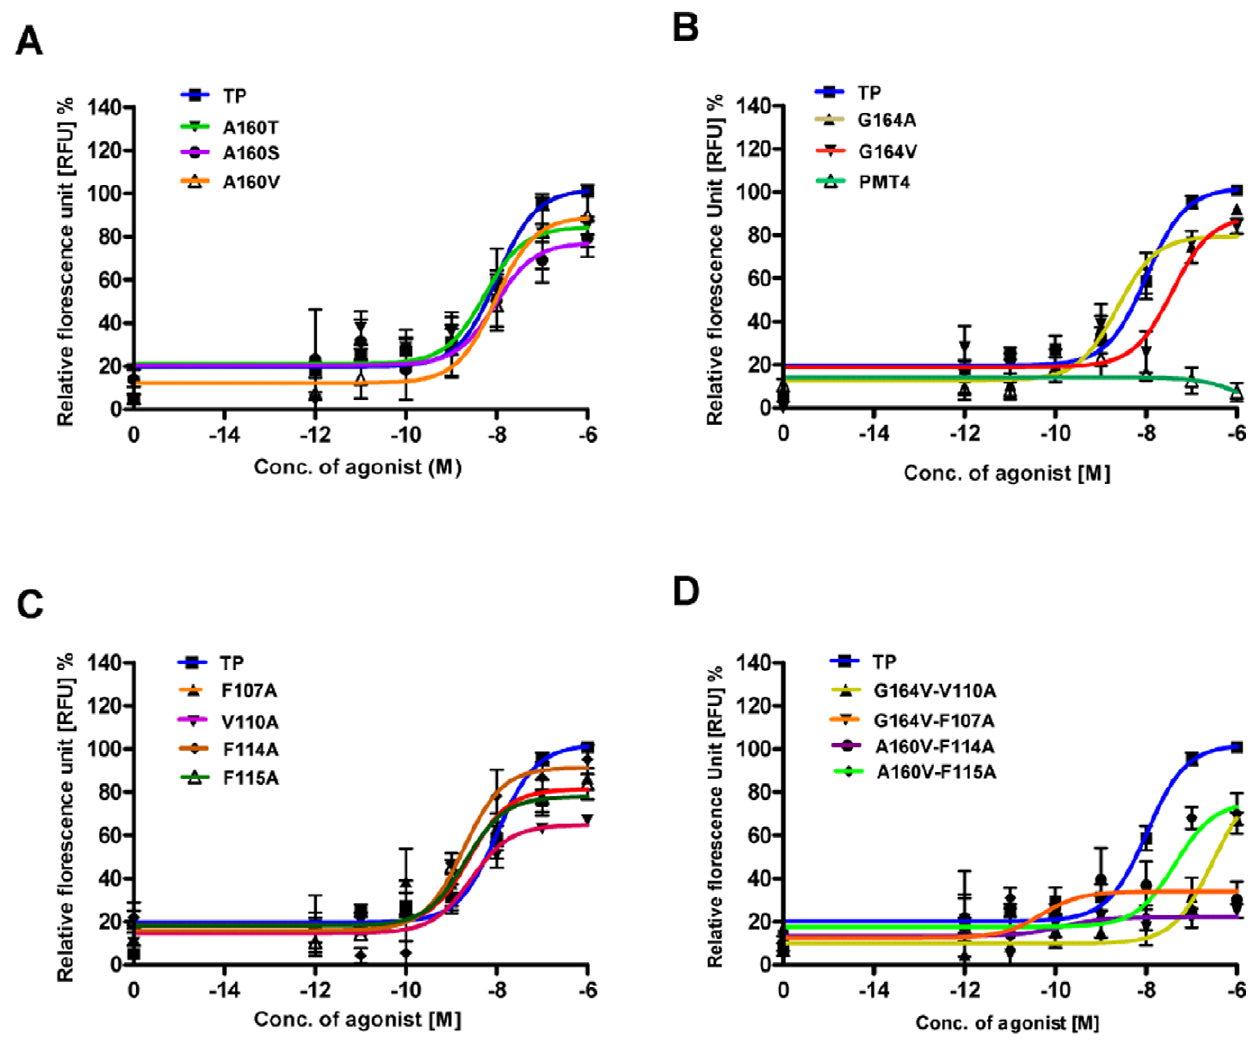
Figure 4. Characterization of G a q-mediated signalling of the TP and mutant receptors. The data shows agonist U46619 induced calcium release for TP, mutants and mock transfected (vector pMT4) HEK293T cells, and is expressed as a percentage of the TP activity. Ala160 mutants (panel A), Gly164 mutants and mock transfected cells (panel B), TM3 mutants (panel C) and double mutants (panel D). The results are from at least three independent experiments performed in